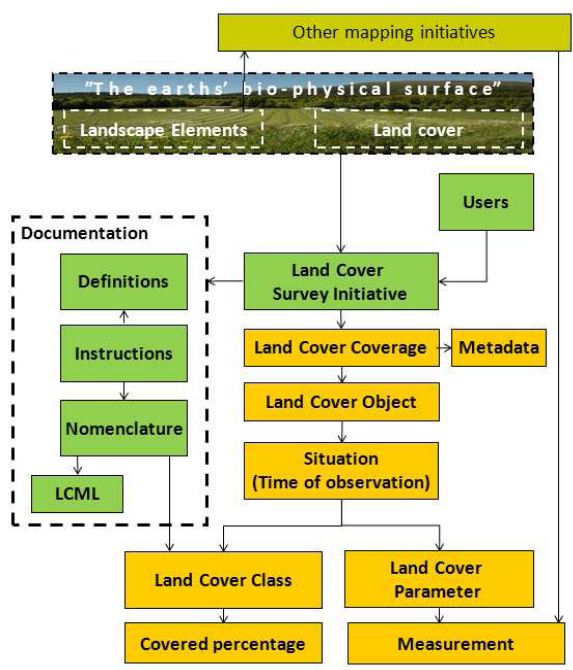
Figure 3. An informal rendition of the complete INSPIRE land cover data model (INSPIRE Thematic Working Gro- up Land Cover,